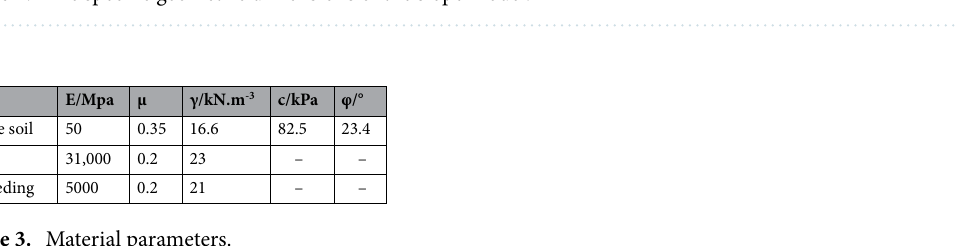
Table 2. The specific geometric dimensions of the slope model.